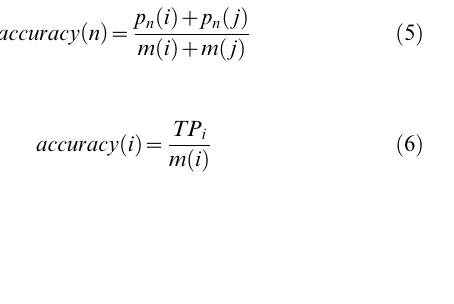
Table 5. Performance comparison of different methods on 25PDB dataset.